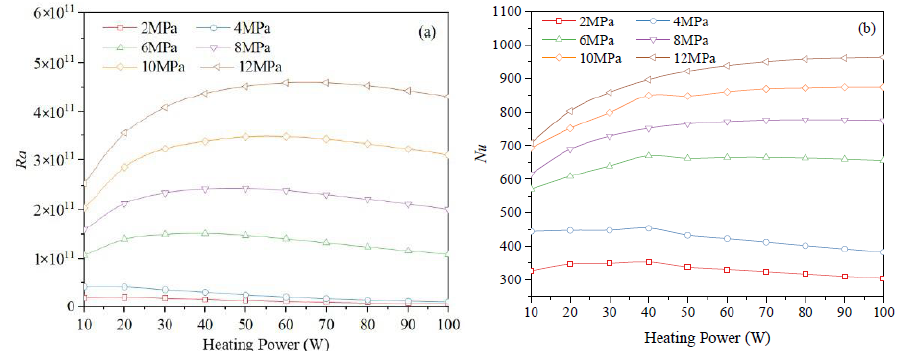
Figure 12. Variations of Ra ( a ) and Nu ( b ) with heating power under different inflation